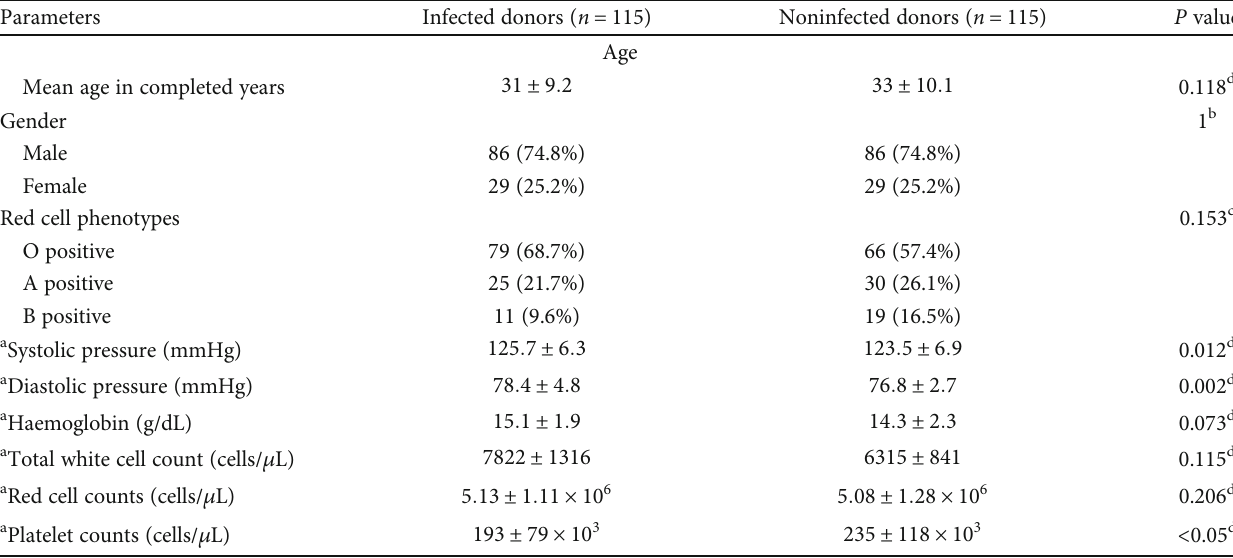
Table 1: Characteristics of the blood